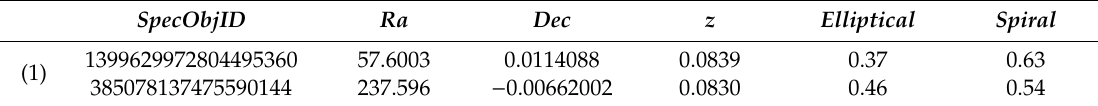
Table 10. Spiral galaxy pair with the best accuracy in ra , dec , and z in catalog [39] for the e ff ect of cosmic mirror. Accuracy is of 0.005 ◦ for ra and dec and 0.001 for z . SpecObjID is ID of optical spectroscopic object in